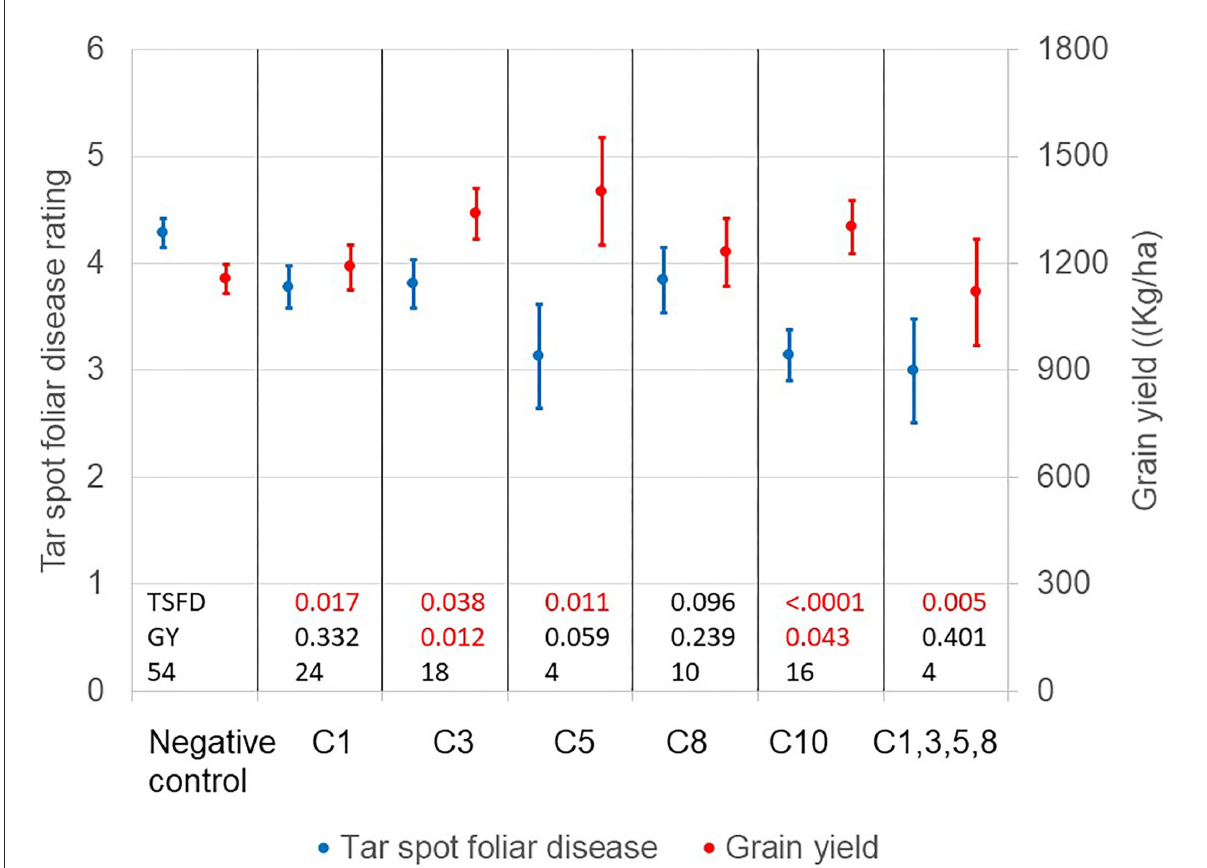
FIGURE6 Confirmation Trial 2014. Second foliar leaf damage ratings and yield from previously unevaluated accession-topcross entries selected for state ( + /-) of favorable alleles at five highly significant SNP regions identified in 2012 trials. Negative check without any favorable alleles; C1 = favorable allele identified on chromosome 1 (S1_287736035); C3 = favorable allele identified on chromosome 3 (S3_ 2861473); C5 = favorable allele identified on chromosome 5 (S5_19462129); C8 = favorable allele identified on chromosome 8 (S8 _138133667); C10 = favorable allele identified on chromosome 10 (S10_134718316); C1,3,5,8 = single accession topcross with multiple identified favorable alleles (c10 missing data). Mixed model results for the analysis of TSFD and GY. Adjusted means (dots) and standard errors (vertical lines) are represented in the figure. P -values compare the adjusted means for each set of TC against the set of negative controls. Values lower than 0.05 are highlighted in